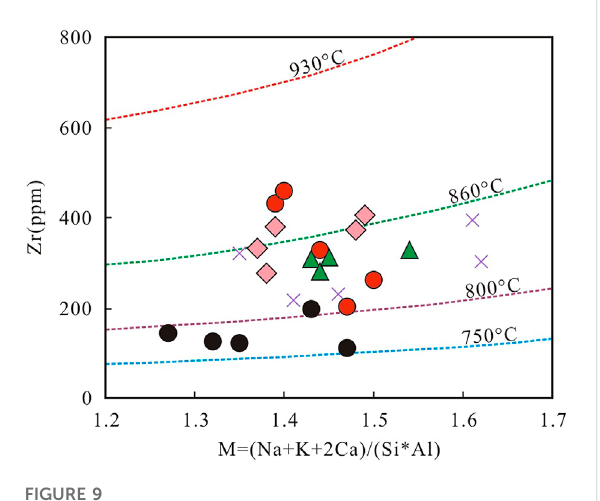
FIGURE 9 M values versus Zr content diagram (adapted from Gao et al., 2021) for the granite in Chuhuertu. Symbols are the same as in Figure